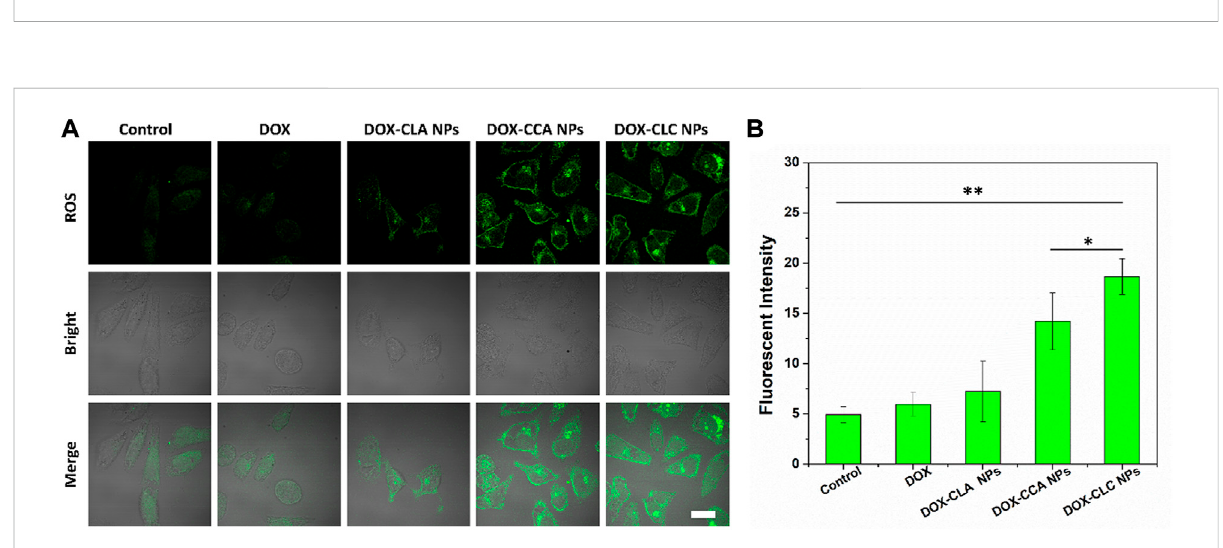
FIGURE 5 In vitro ROS evaluation of each sample in HepG2 cells observed by CLSM, scale bar = 10 um (A) ; Quantitative analysis of the ROS fl uorescence intensity measured by ImageJ (B) ; * represents p < 0.05; ** represents p <